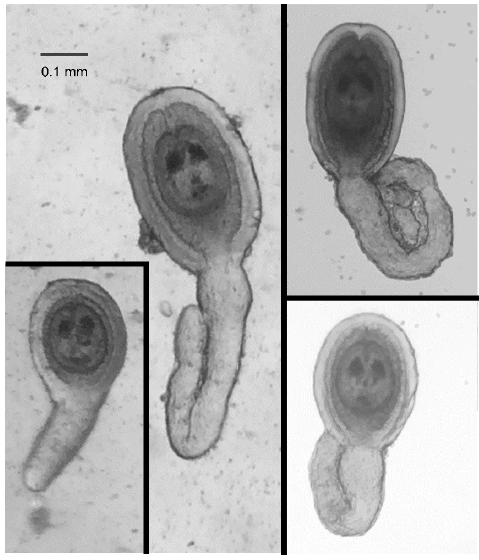
Figure 3. Typical HDCs. HDCs vary in size over roughly a 5-fold range, and have substantial morphological variation in their “tail”. Photographs shown were taken using iPhone 6 cameras and either an OMAX dissecting microscope with a iDu LabCam Microscope Adapter for the iPhone ( Left images) or a Wilovert inverted microscope ( Right images) by two coauthors (CM and ZEH) working independently.